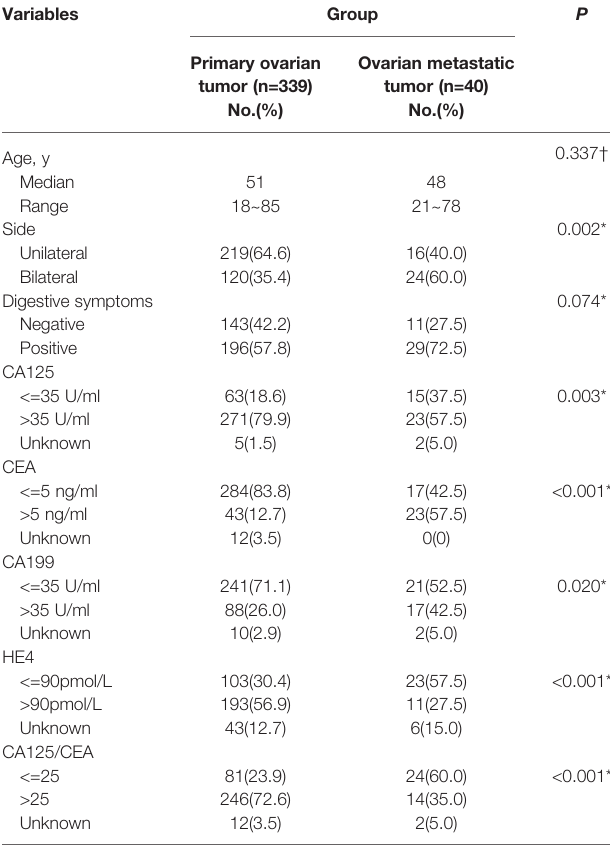
TABLE 1 | Demographic and clinical-pathological